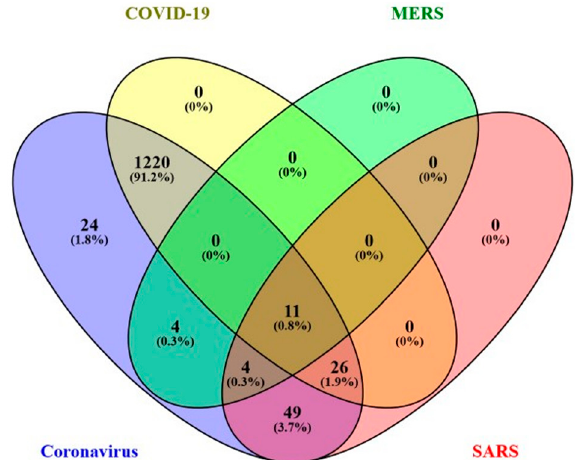
Figure 2. The coronavirus disease gene distribution among the parent term (Coronavirus infectious disease) and its three child terms: COVID-19, Middle East respiratory syndrome (MERS) and severe acute respiratory syndrome (SARS). The numbers in each area represent the gene count of that section and the percentage to all the coronavirus infectious disease genes. There are 1257 genes associated with COVID-19, 19 genes associated with MERS and 90 genes with SARS, totaling 1338 coronavirus infectious disease genes on display.